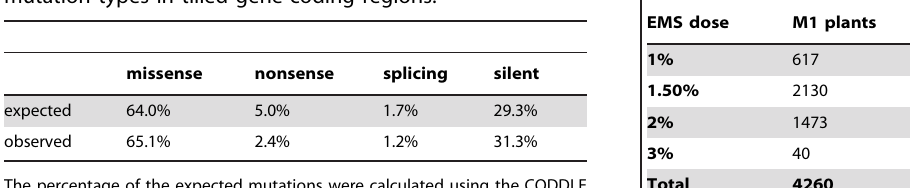
Table 3. Expected and observed frequencies of induced mutation types in tilled gene-coding regions.